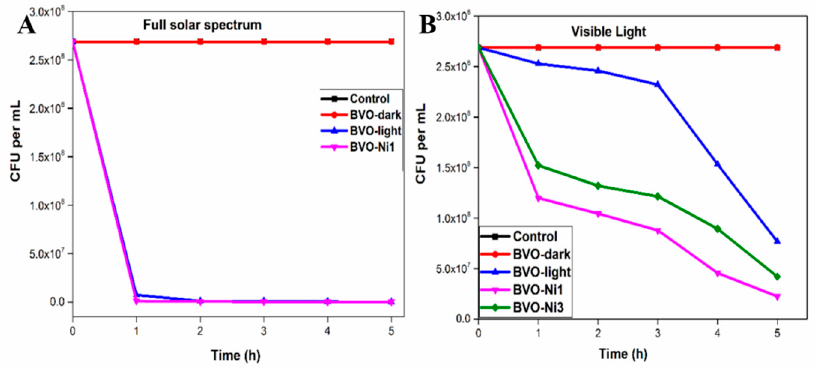
Figure 13. Inactivation of E. coli on: ( A ) Irradiation to full solar spectrum light; ( B ) visible light [354].